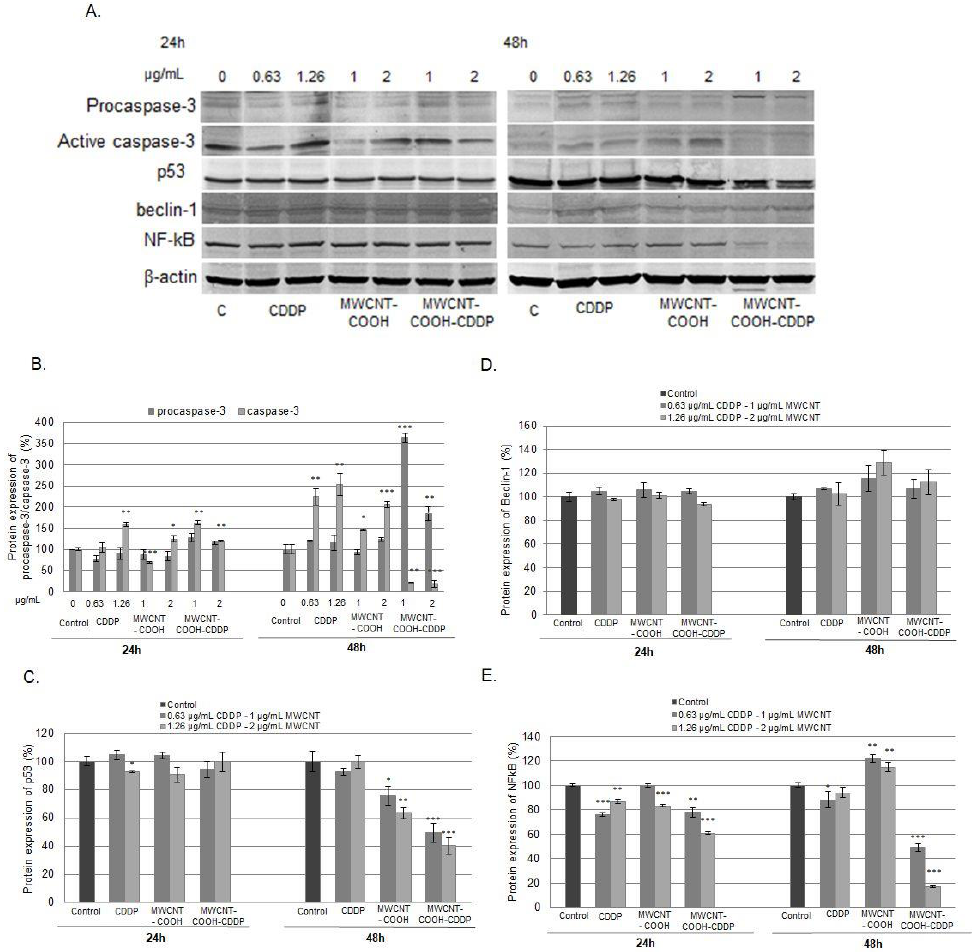
Figure 13. Relative protein expressions of procaspase-3/caspase-3 ( B ), p53 ( C ), Beclin-1 ( D ) and NF- κ B ( E ) after the exposure of MDA-MB-231 cancer cells to 0.63, 1.26 µ g/mL CDDP and 1, 2 µ g/mL MWCNT for 24 h and 48 h. The graphs are the correspondent quantification of blot images ( A ). The results are calculated as the mean ± SD of 3 replicates and represented relative to control. * p < 0.05, ** p < 0.01, *** p < 0.001 vs. control.